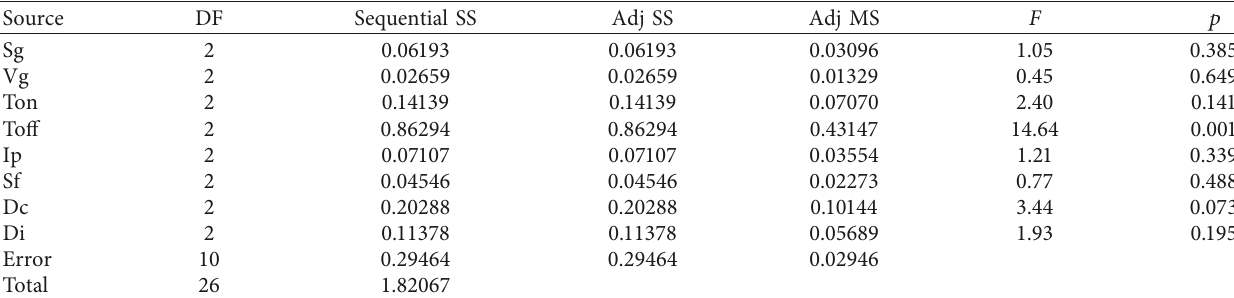
Table 18: ANOVA for composite principal component ( ψ ) using adjusted SS for